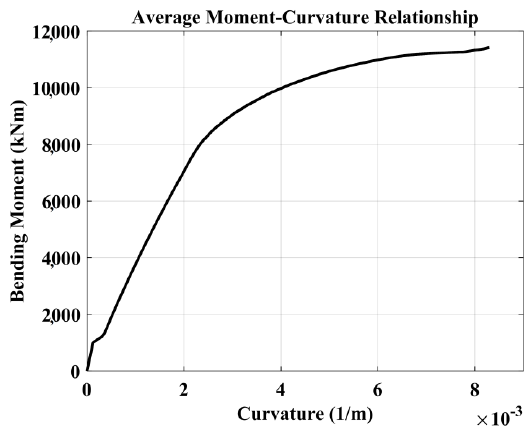
Figure 12. Pile section ‘bending moment-curvature’ relationship for B7 pile section.